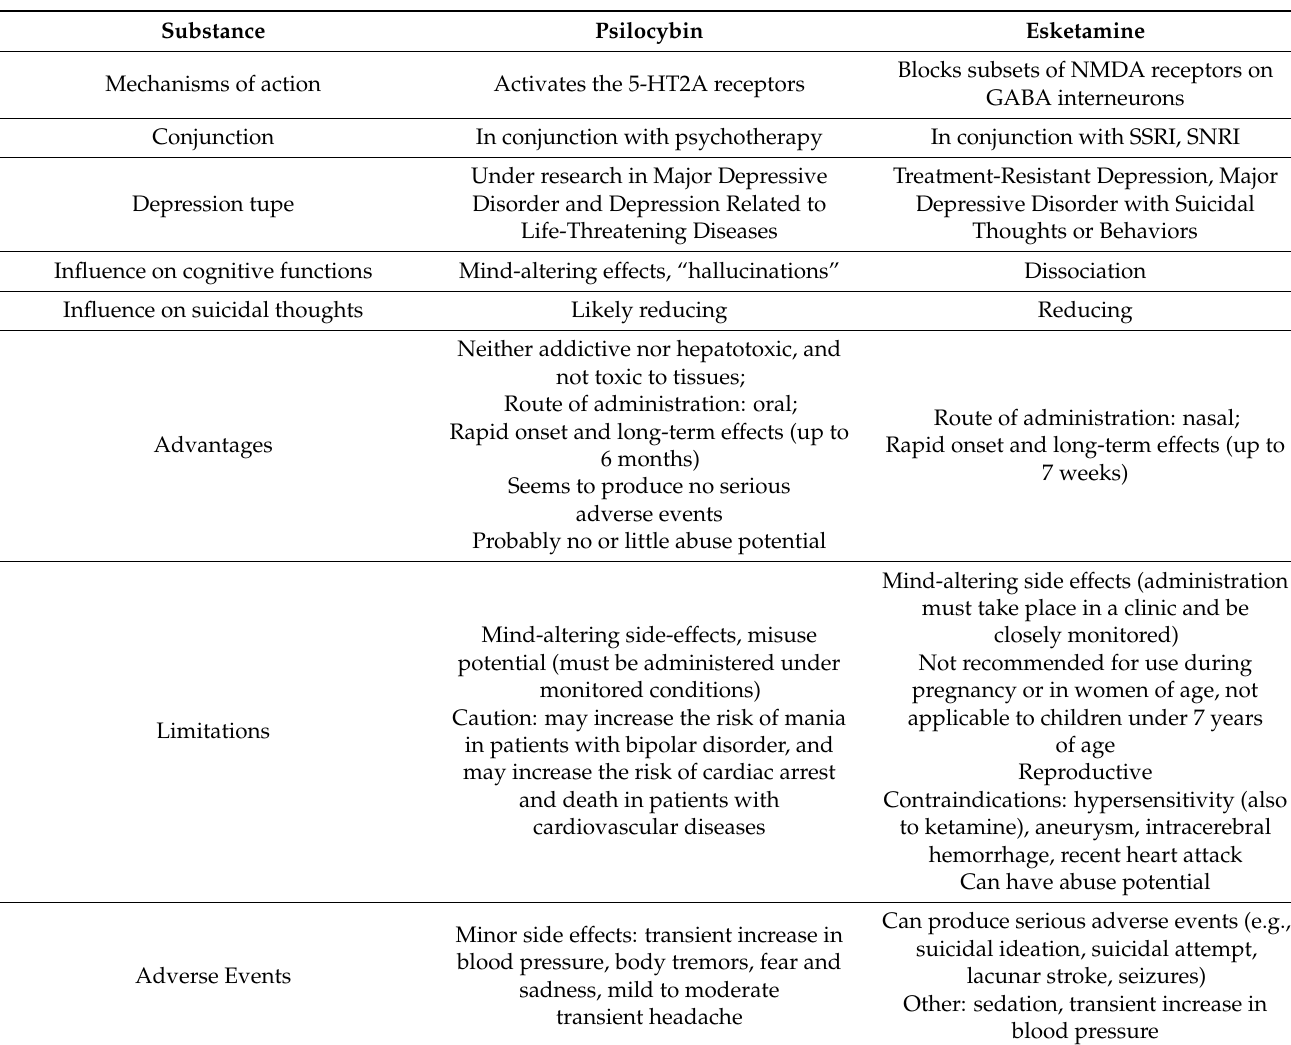
Table 8. Summary of psilocybin and esketamine